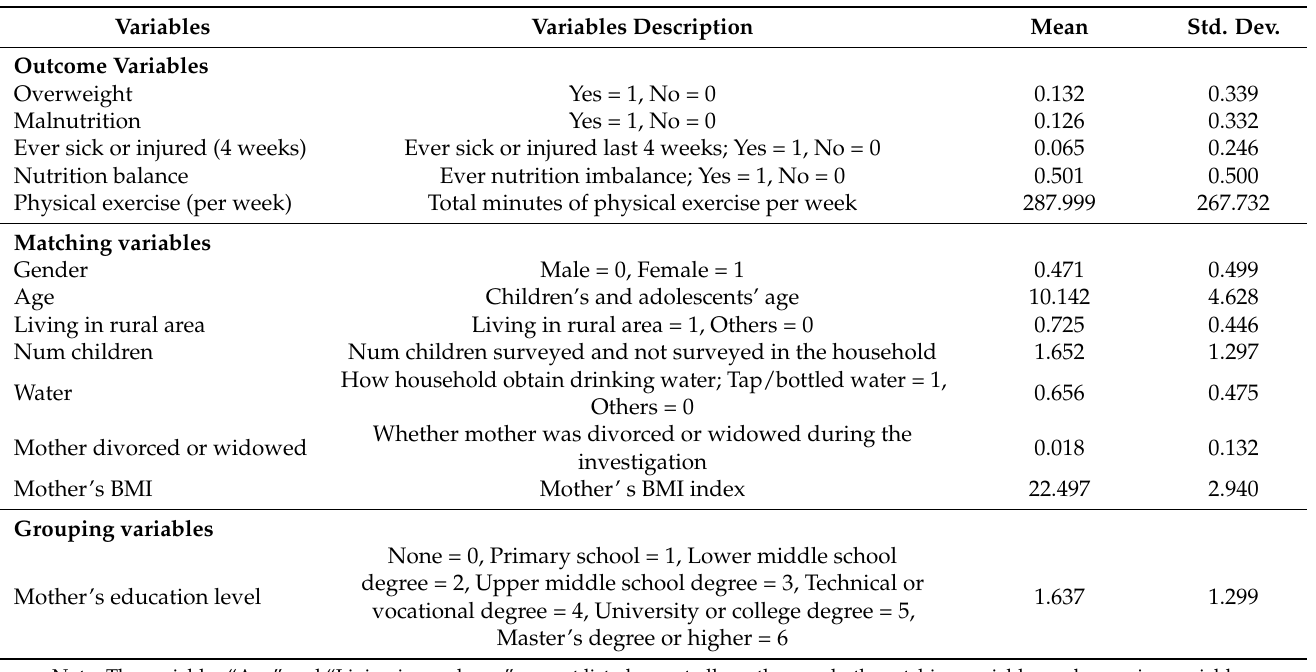
Table 1. Variables’ description and descriptive